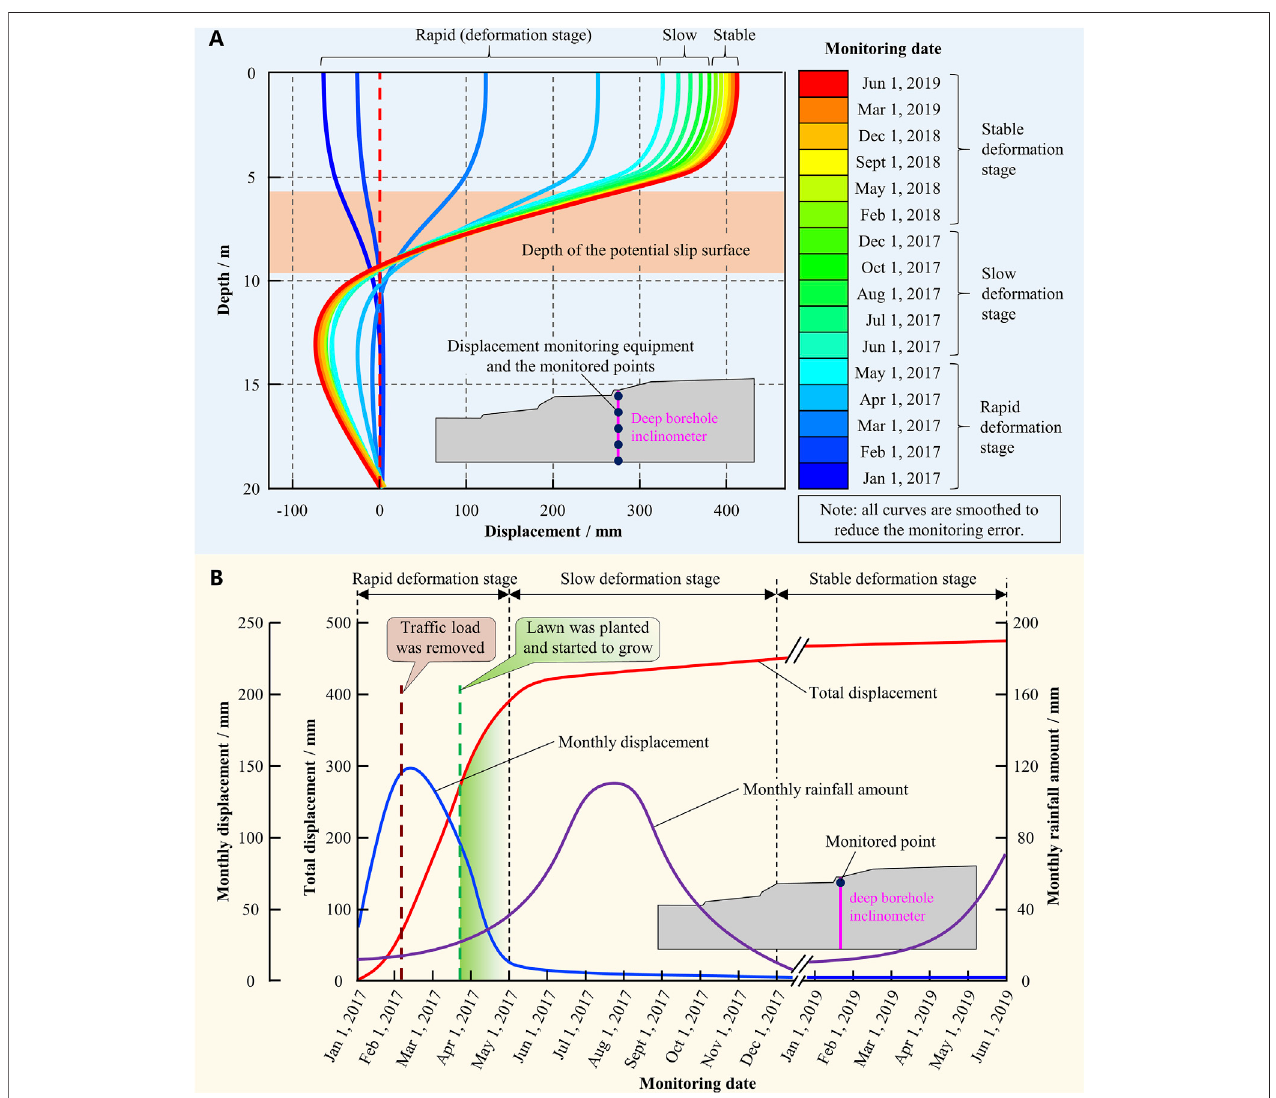
FIGURE10| Distributionofhorizontal deformationalongthedepth (A) anddevelopmentofhorizontal deformationonthesurface (B) oftheslopemonitored bythe deep borehole inclinometer.